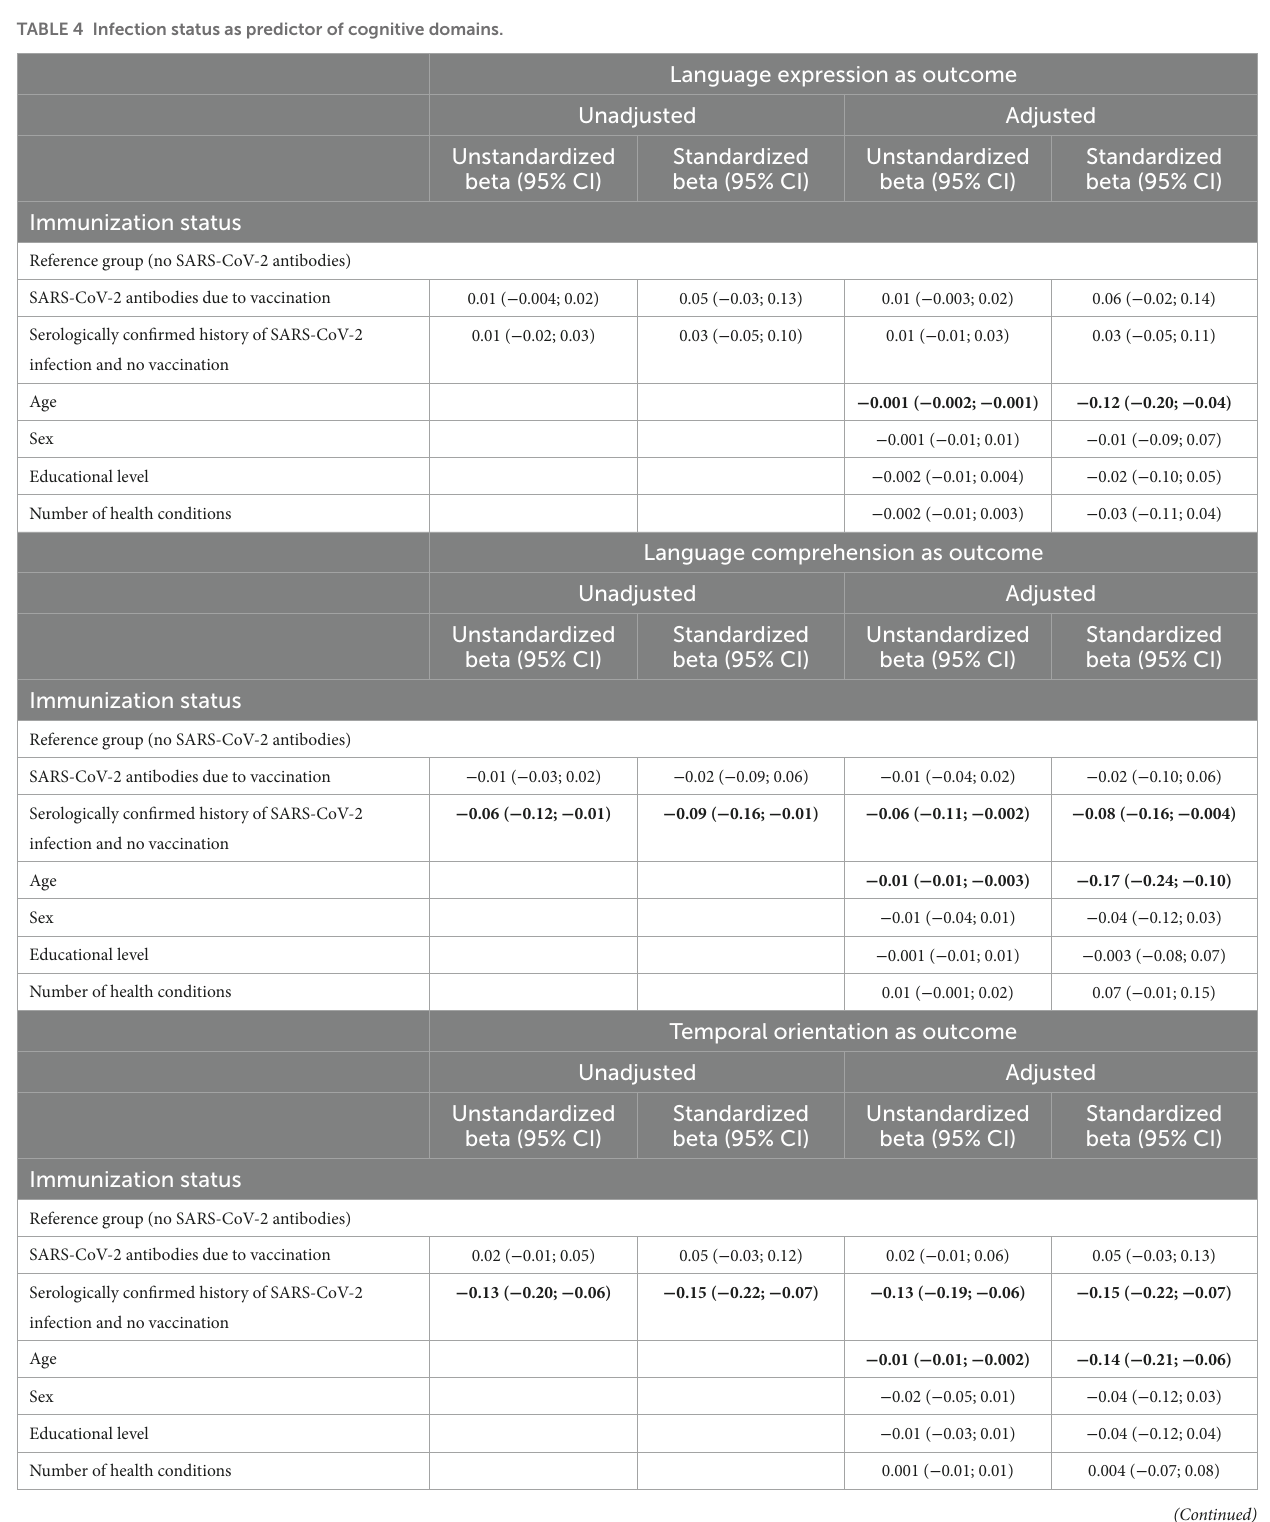
TABLE 4 Infection status as predictor of cognitive